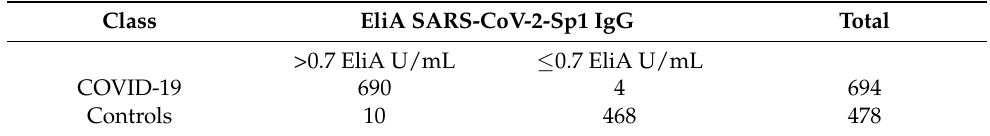
Table 3. Stratification of samples from 694 COVID-19 patients, and 478 healthy Controls at 0.7 EliA U/mL cut-off and 97.9% specificity in an internal study.